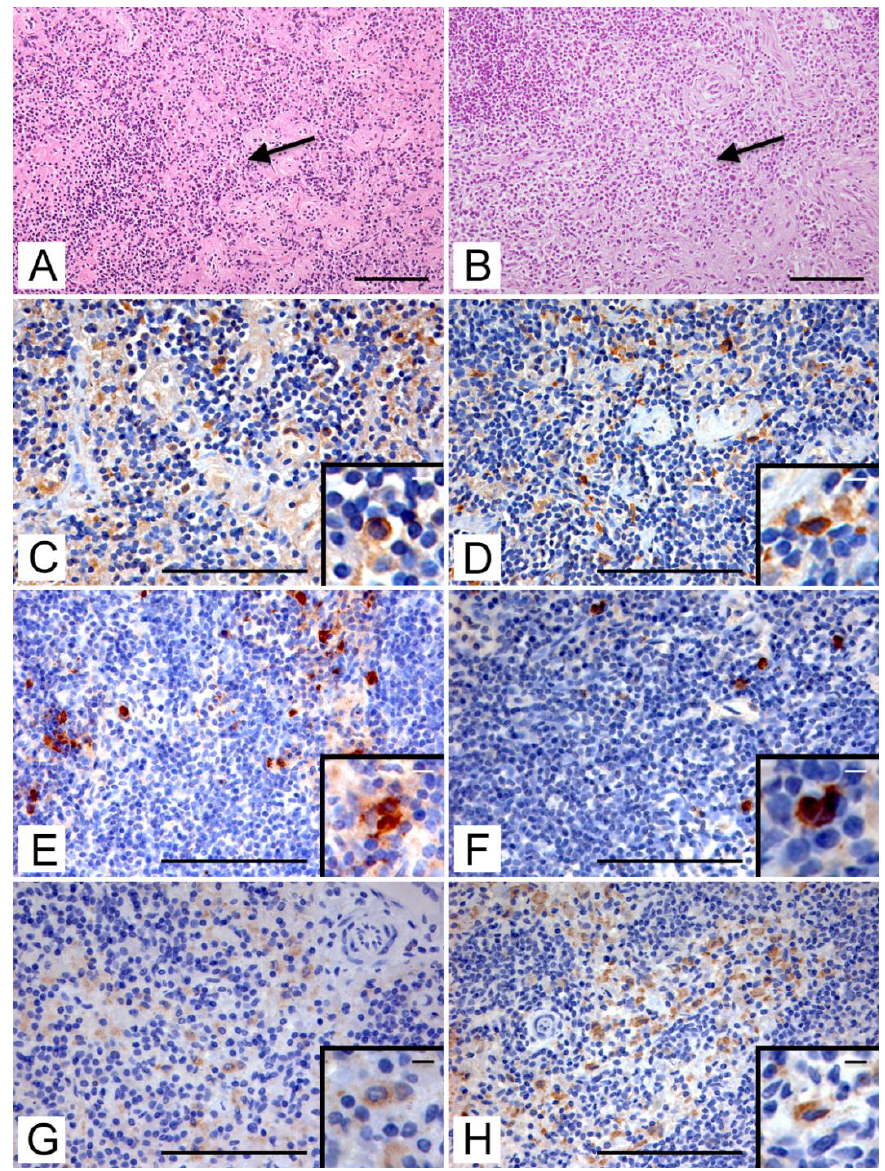
Figure 3. Immunolocalization of macrophages on lymph node tissue. ( A ) Roe deer. Lymph node medullary area (arrow; H-E, bar = 100 µ m). ( B ) Fallow deer. Lymph node medullary area (arrow; H-E, bar = 100 µ m). ( C ) Roe deer. Immunohistochemical staining with anti-Iba-1 antibody in the medulla (IHC, bar = 100 µ m). Inset: Iba-1-positive macrophagic cells in the medullary area (IHC; bar = 10 µ m). ( D ) Fallow deer. Immunohistochemical staining with anti-Iba-1 in the medulla (IHC, bar = 100 µ m). Inset: Iba-1-positive macrophagic cells in the medullary area (IHC; bar = 10 µ m). ( E ) Roe deer. Immunohistochemical staining with anti-Calprotectin (MAC387) anti- body in macrophages and granulocytes in the medulla (IHC, bar = 100 µ m). Inset: MAC387-positive macrophagic cells in the medullary area (IHC; bar = 15 µ m). ( F ) Fallow deer. Immunohistochemical staining with anti-Calprotectin (MAC387) antibody in scattered macrophages and granulocytes in the medulla (IHC, bar = 100 µ m). Inset: MAC387-positive macrophagic cells in the medullary area (IHC; bar = 10 µ m). ( G ) Roe deer. Immunohistochemical staining with anti-CD163 (AM-3K) antibody in the medulla (IHC, bar = 100 µ m). Inset: CD163-positive macrophagic cells in the medullary area (IHC; bar = 10 µ m). ( H ) Fallow deer. Immunohistochemical staining with anti-CD163 (AM-3K) antibody in the medulla (IHC, bar = 100 µ m). Inset: CD163-positive macrophagic cells in the medullary area (IHC; bar = 10 µ